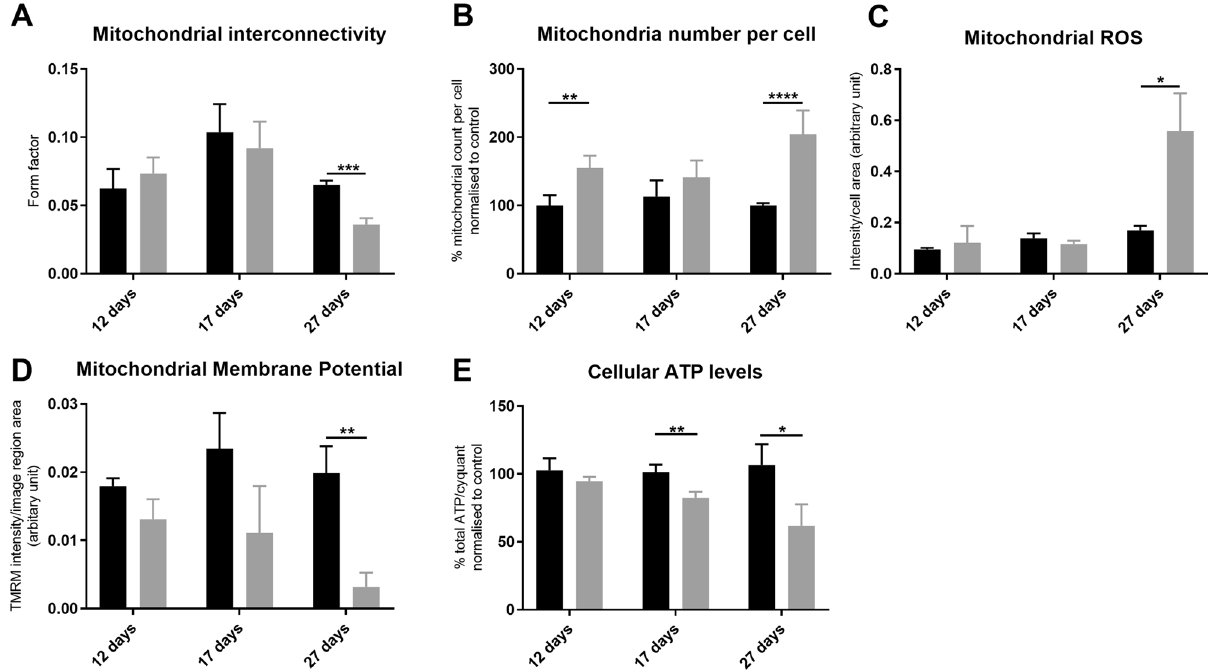
Figure 3. Mitochondrial morphology and function in dopaminergic iNeurons throughout differentiation. ( A ) Mitochondria in both control (black bars) and PRKN mutant patient neurons (grey bars) elongate as the metabolic switch from glycolysis to oxidative phosphorylation begins at day 17 of differentiation. By day 27 of differentiation mitochondria in PRKN mutant patient neurons are fragmented compared to control neurons (***p = 0.0004). ( B ) Mitochondrial number is increased in PRKN mutant neurons (grey bars) compared to controls (black bars); (at day 12 **p = 0.008 and day 27 ****p < 0.0001). ( C ) Mitochondrial ROS production is significantly increased at day 27 of differentiation in PRKN mutant neurons (grey bars) compared to controls (black bars; *p = 0.037). ( D ) Mitochondrial membrane potential is decreased in PRKN mutant patient neurons (grey bars) throughout differentiation, however the most dramatic and only significant reduction is at day 27 of differentiation (**p = 0.003). E shows cellular ATP levels are reduced in PRKN mutant patient neurons at day 17 (**p = 0.005) and day 27 (*p = 0.01) of differentiation. All experiments were repeated on three separate rounds of differentiation in each control and PRKN mutant patient line (four different controls and PRKN mutant patient lines are included). Bar graphs represent mean with SD. All statistics done by two-way ANOVA test using Sidaks multiple comparisons